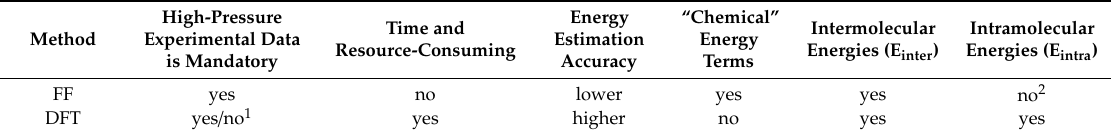
Table 1. Advantages and disadvantages of DFT and FF methods applied for high-pressure research of organic